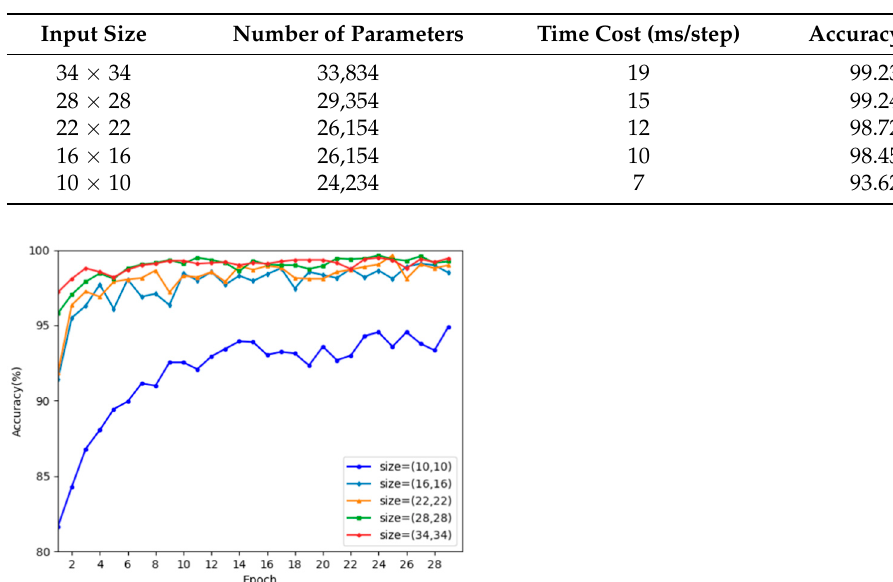
Table 2. Tests on the trajectory diagrams of different sizes.